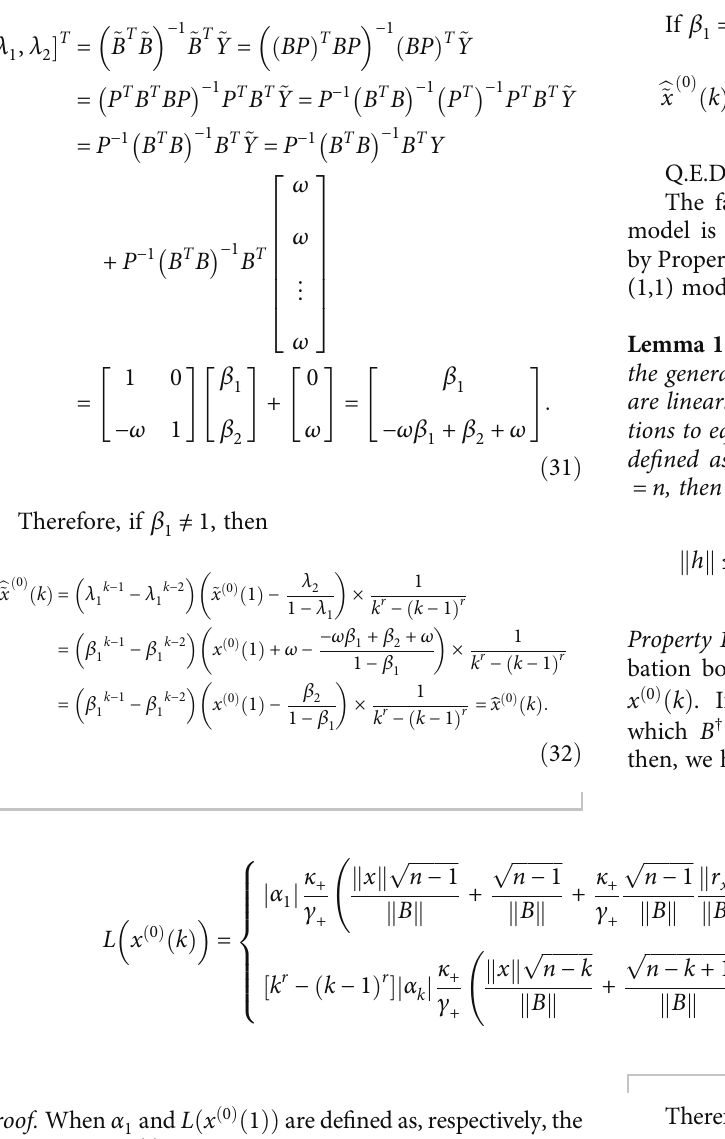
ffiffiffiffiffiffiffiffiffiffi p ffiffiffiffiffiffiffiffiffiffi n − 1